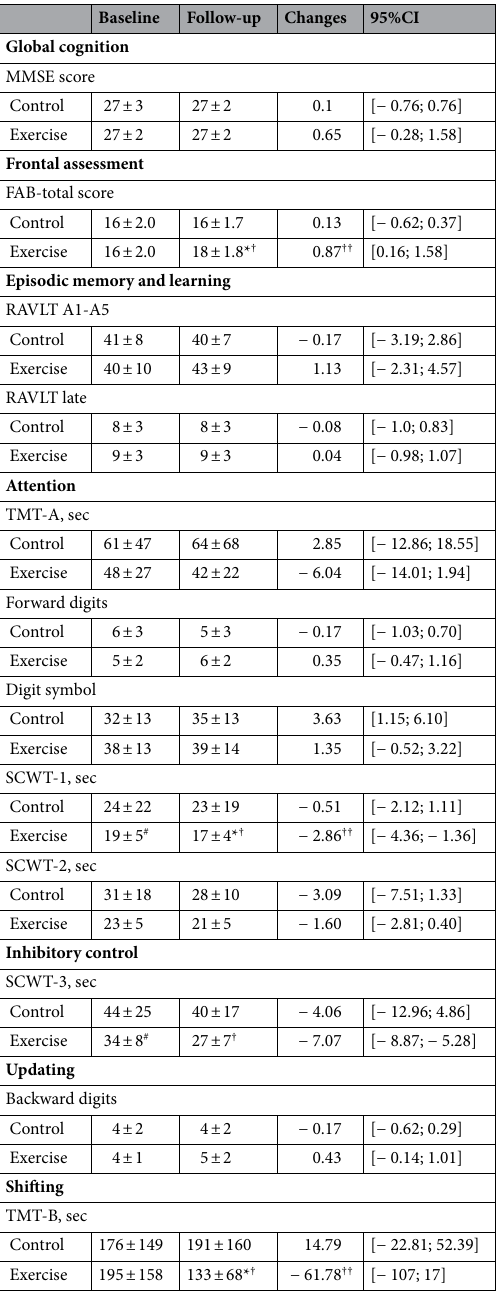
Table 3. Attention, memory, and executive functioning among individuals with obstructive sleep apnea in the control and training groups at baseline and after follow- up, taking into consideration the APOE ε4 allele. Data are means ± SD and means of delta changes [95% CI]. MMSE Mini-Mental State Examination; FAB Frontal Assessment Battery; RAVLT A1-A5 Rey Auditory Verbal Learning Test (sum of 5 recall trials of 15 words); RAVLT late delayed recall after 30 min; TMT Trail Making Test; SWCT Stroop Color Word Test. P value indicates comparisons between groups (2-way ANOVA). *Within group comparison, P < 0.05. † Between group comparisons in post intervention, P < 0.05. # Between group comparisons in pre intervention, P < 0.05 (detected by post hoc analysis). † † Change between groups (Unpaired t test)